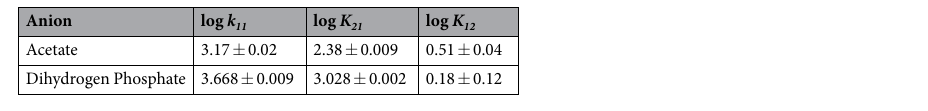
Table 1. Binding constants for the interaction between 4 and an anion as determined by 1 H NMR spectroscopy using HypNMR